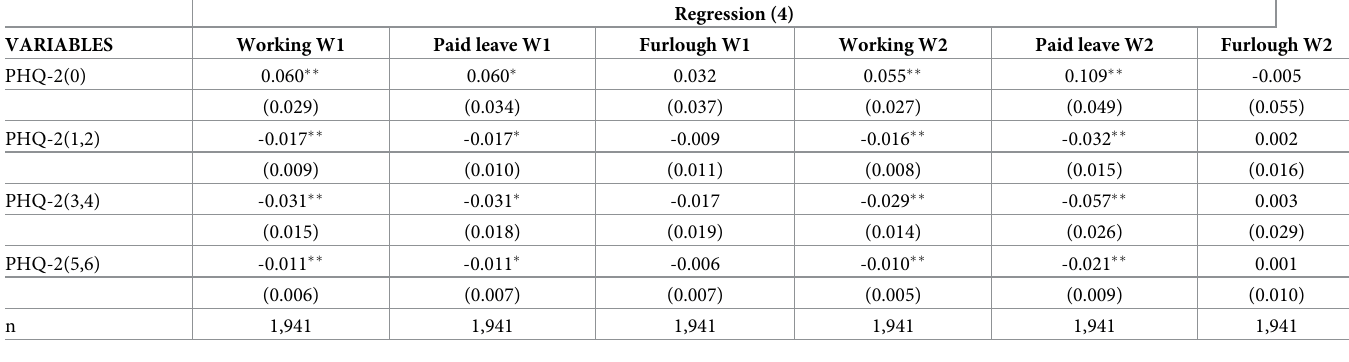
Table 5. Marginal effects (Regression